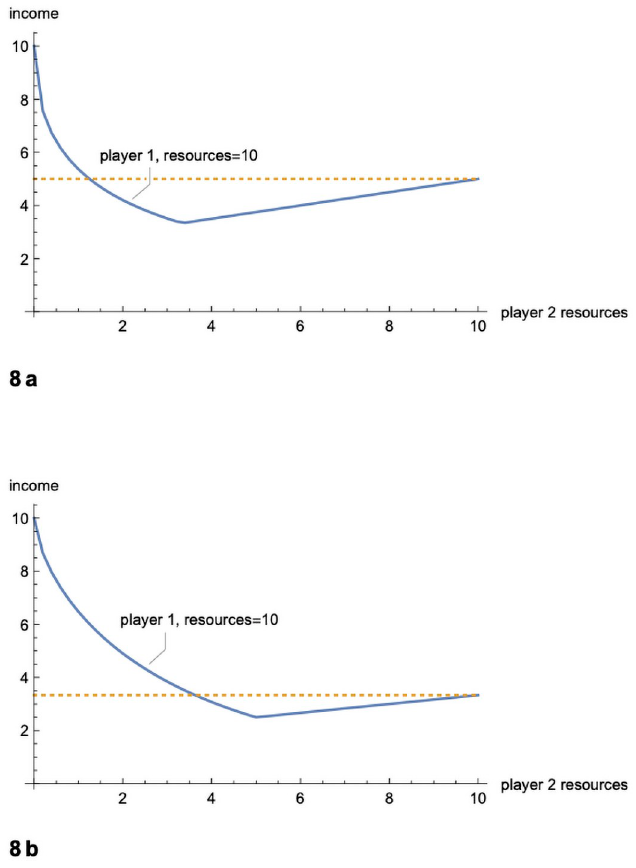
Fig 8. Decisive battle and the end of the barbarian age. a. (A reprise of Fig 1). Income in the two person game for player 1, resources = 10, facing player 2, varying resources, assuming less decisive “ancient” warfare, m = 1. Dashed line is income in an equal contest. b. Income in the two person game for player 1, resources = 10, facing player 2, varying resources, assuming more decisive “modern” warfare, m = 2. Dashed line is income in an equal contest.